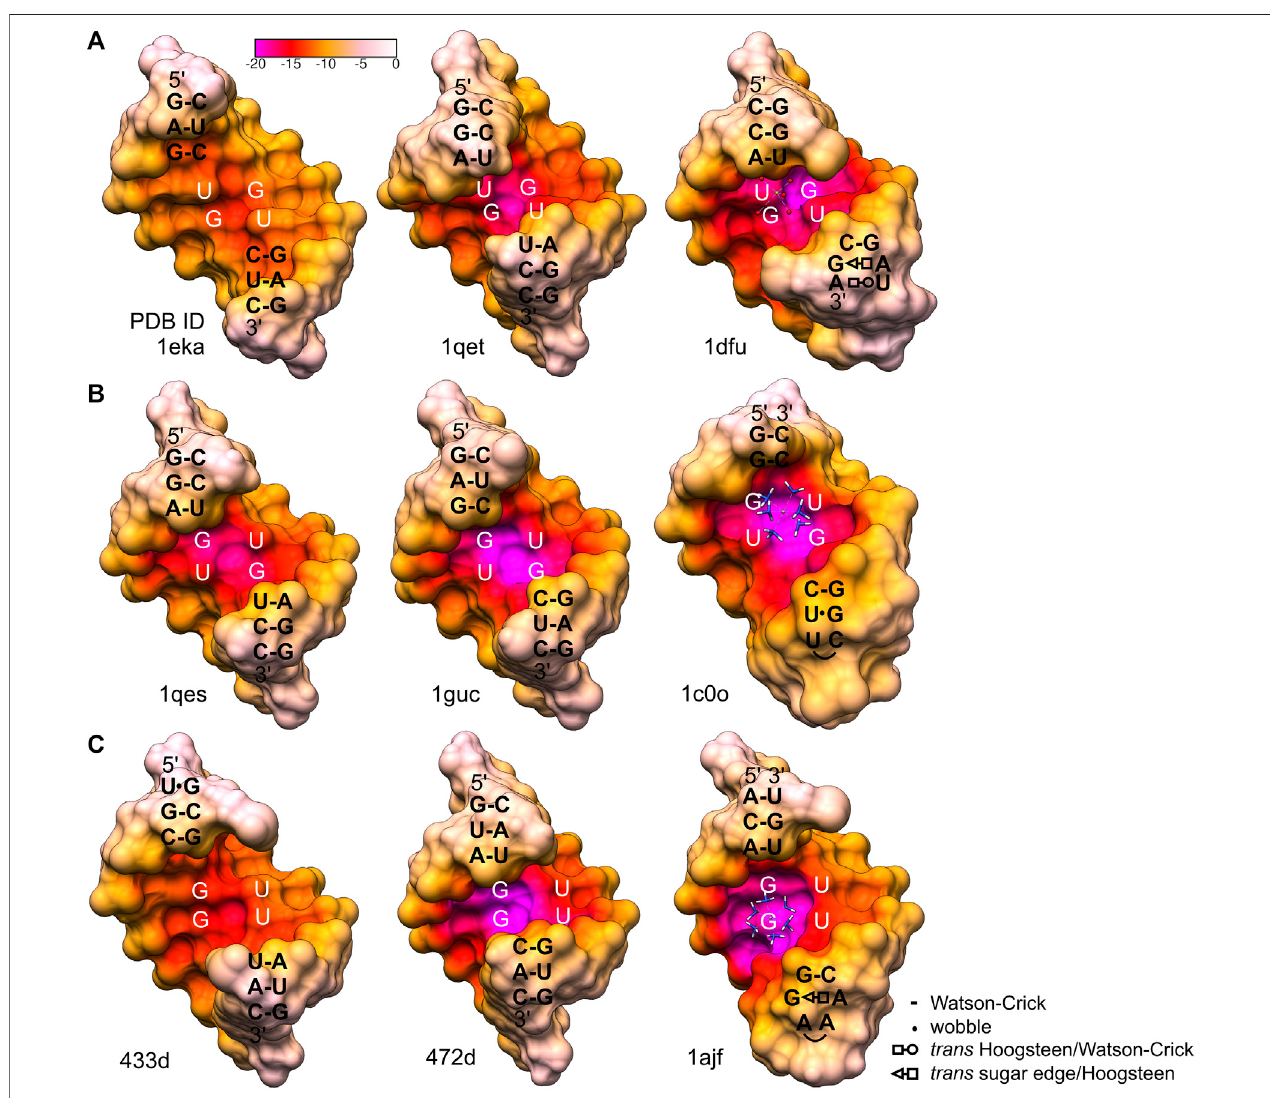
FIGURE 6 | Electrostatic potential of the major grooves found in the X-ray and NMR structures containing different types of wobble tandems (McDowell and Turner, 1996; Kieft and Tinoco, 1997; McDowell et al., 1997; Colmenarejo and Tinoco, 1999; Trikhaet al., 1999; Chenet al., 2000; Deng and Sundaralingam, 2000; Luand Steitz, 2000). (A) 5 ′ UG/3 ′ GUwobbletandem,motifI. (B) 5 ′ GU/3 ′ UGwobbletandem,motifII.1c0oshowstheP5hairpinofagroupIintroncomplexedwith[Co(NH3) 6 ] 3+ . (C) 5 ′ GU/ 3 ′ GUwobbletandem,motifIII.1ajfisamodelofagroupIintronP5bstem – loopstructurecomplexedwith[Co(NH3) 6 ] 3+ .Theelectrostaticsurfacewascalculatedbythe APBS/PDB2PQR server using default settings (Baker et al., 2001; Dolinsky et al., 2004; Jurrus et al., 2018). The original structures 1dfu, 433d, and 1ajf were truncated to (cid:129) octamers to correspond to the other presented motifs. Interactions in sequences fl anking the G U tandem motifs are represented as shown in the legend, according to (Leontis et al.,